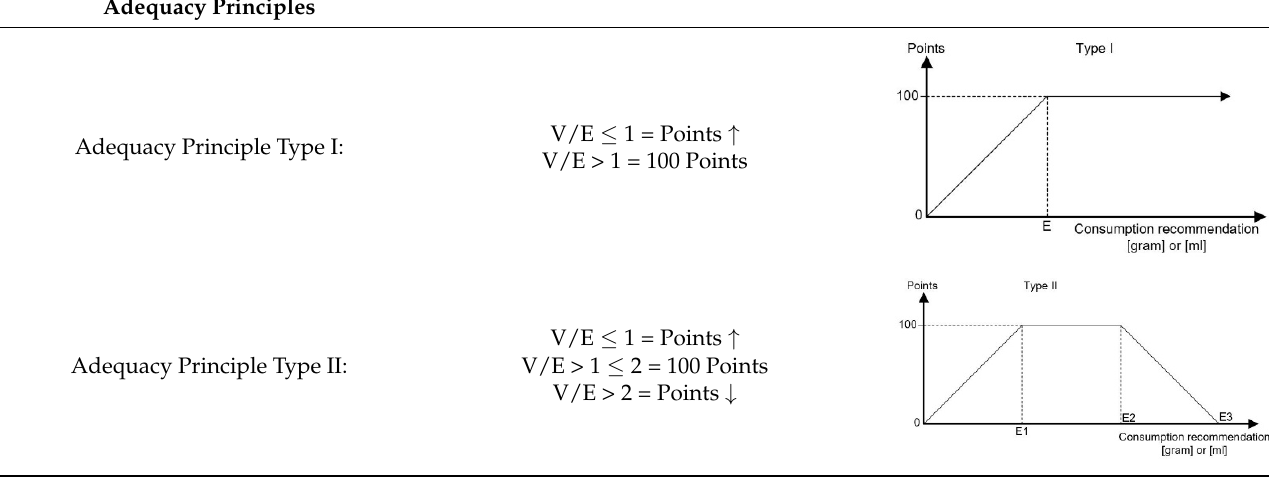
Table A1. Valuation principles.